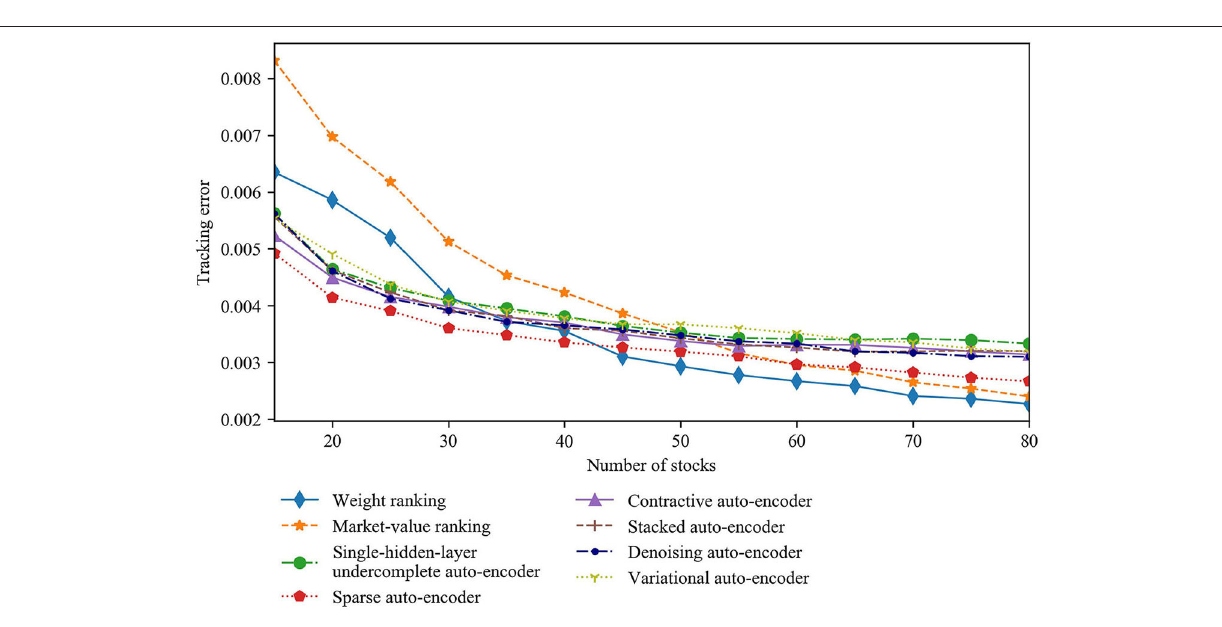
However, the strategy based on the variational auto-encoder does not perform better than that based on single-hidden- layer undercomplete auto-encoder. This can also be